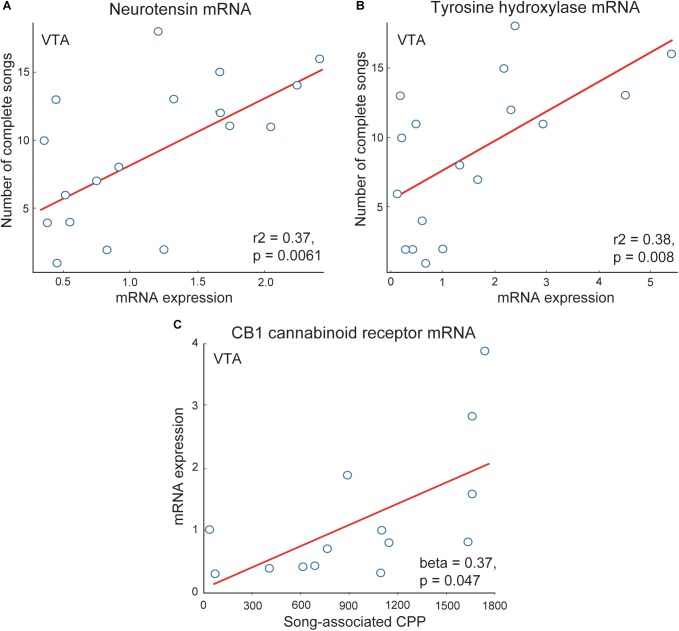
Correlations support roles for neuromodulators in VTA in flocking behavior in starlings. Positive correlations between flock song on the y-axis and measures of (A) neurotensin and (B) tyrosine hydroxylase mRNA in VTA. (C) Positive correlation between CB1 cannabinoid receptor mRNA on the y-axis and song-associated CPP on the x-axis. Each point represents one individual. Figures redrawn from Merullo et al. (2016) and Hahn et al. (2017).